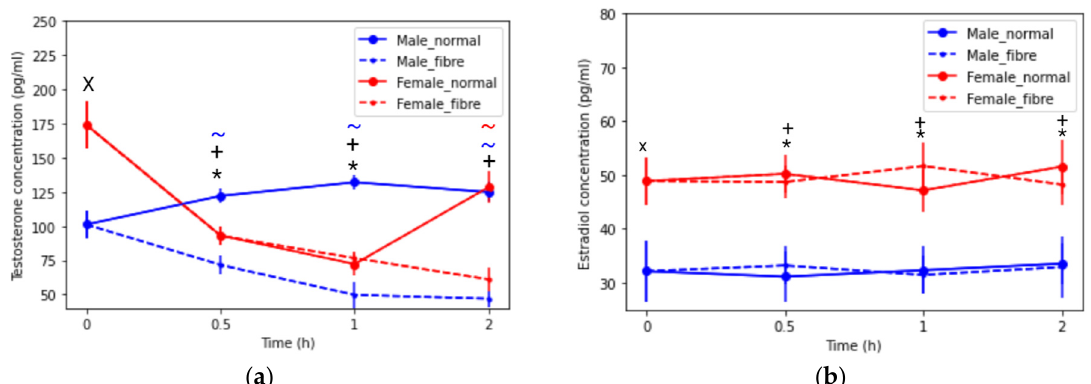
Figure 5. Plasma ( a ) testosterone concentration (pg/mL) and ( b ) estradiol concentration (pg/mL) over time (0 to 2 h) in male and female rats under fasted and fed states (normal meal and fibre meal) (mean ± SD, n = 6). The following symbols denote a statistical significance ( p < 0.05) of a sex difference between male and female rats: fasted state (X), normal meal (*) and fibre meal (+); and a food effect between the feeding interventions: normal and fibre (~).